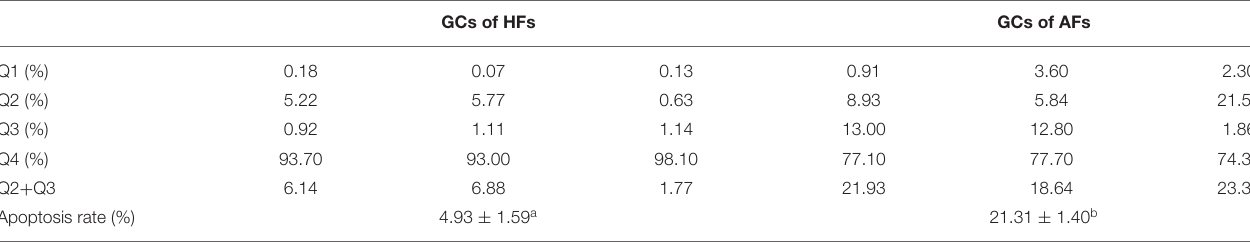
TABLE 2 | Apoptotic rate of GCs in HFs and